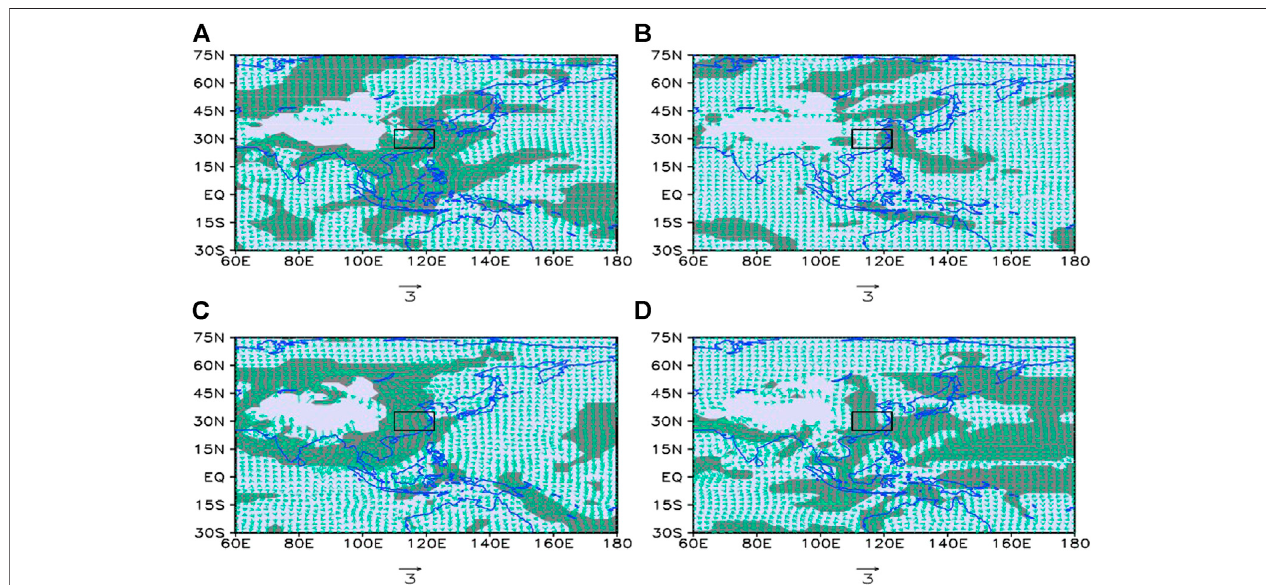
FIGURE4| Regressioncoef fi cientsofthePRRandthe850 hPawind fi eldin (A) spring, (B) summer, (C) autumnand (D) winterintheMLRYR[units:%/(m/s)].The shaded area indicates that the results passed the 95% signi fi cance test and the black rectangle box represents the MLRYR.